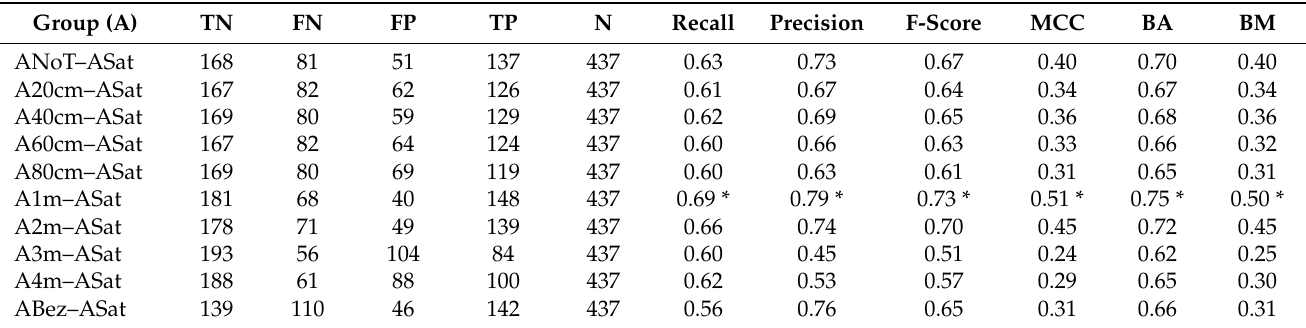
Table 3. The comparison of curve prediction accuracy rates for the rural road in terms of generaliza- tion tolerance values.